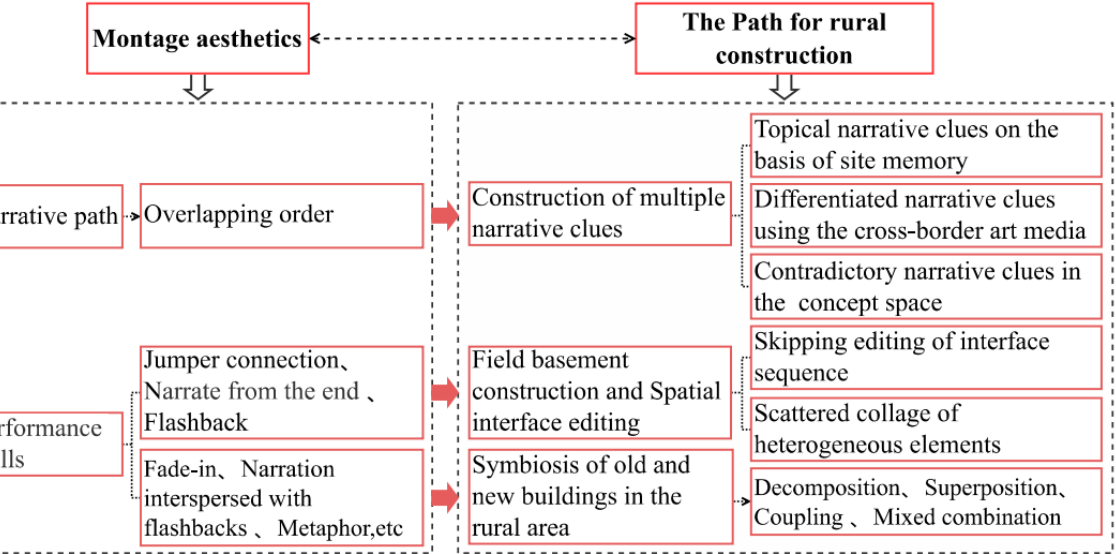
Figure 16. Montage aesthetics and rural construction path (source: the authors).